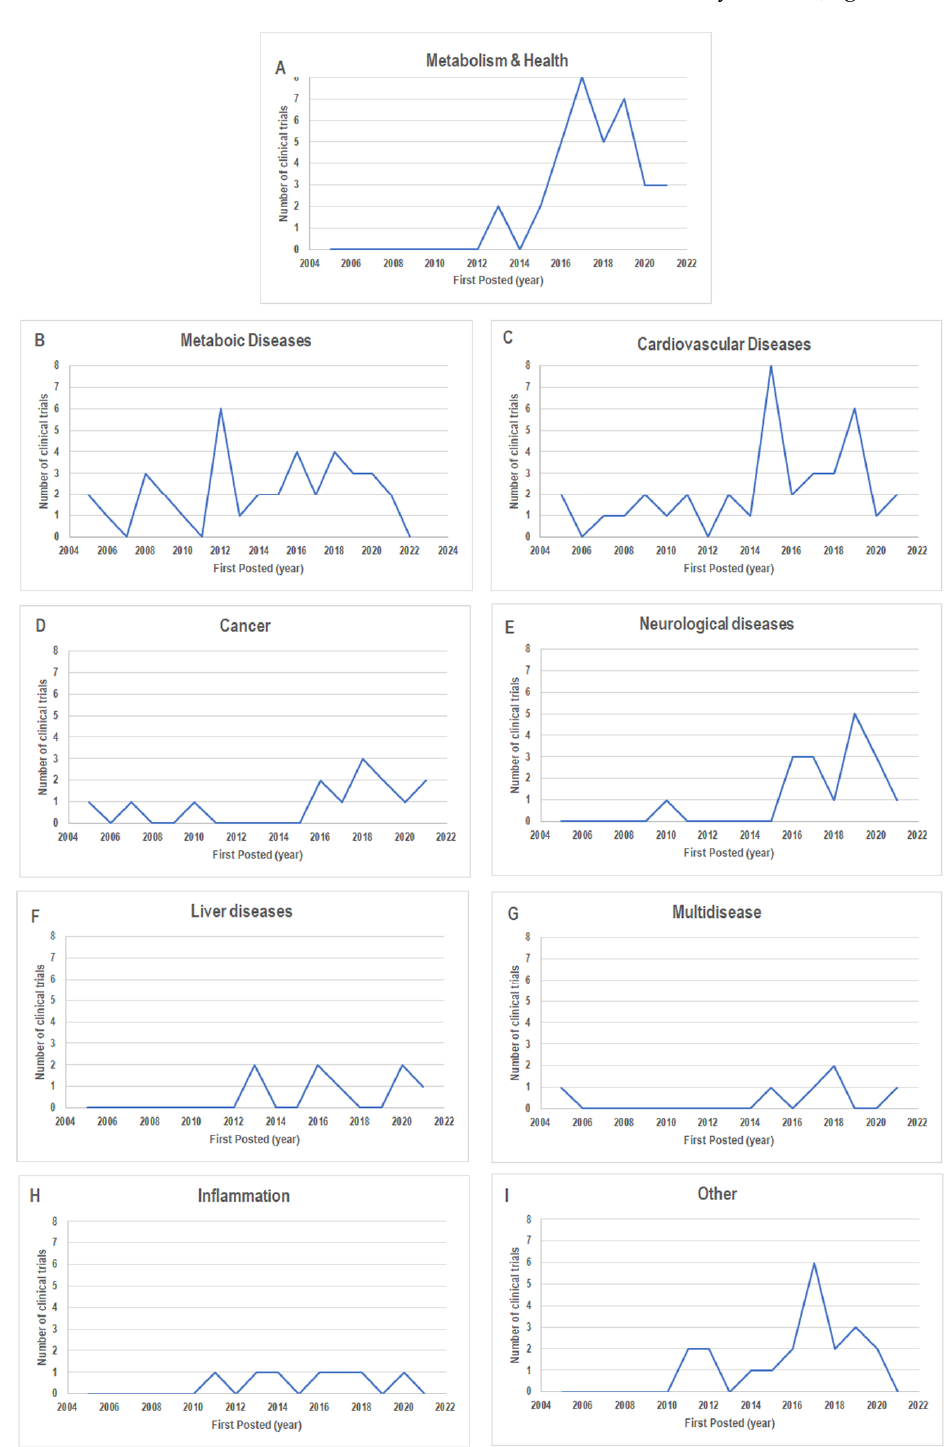
Figure 5. The number of clinical trials for each category classified according to “First posted” as follow: ( A ) Metabolism & Health; ( B ) Metabolic Diseases; ( C ) Cardiovascular Diseases; ( D ) Cancer; ( E ) Neurological Diseases; ( F ) Liver Diseases; ( G ) Multidisease; ( H ) Inflammation; ( I ) Other. Data from http://www.clinicaltrials.gov/ (accessed on 31 January